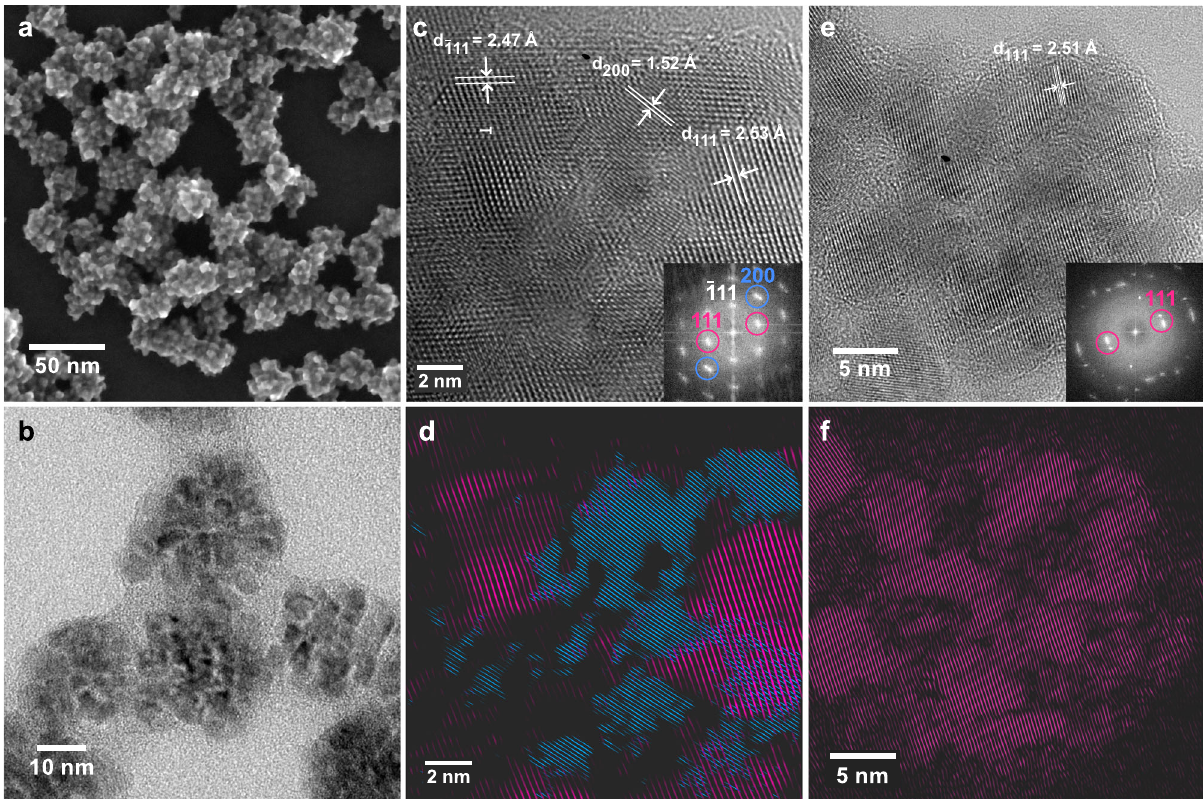
Fig. 1 SEM and TEM images of CoO assemblies at the end of the reaction. Different magni fi cations highlight their hierarchical structure. a Probe- corrected SEM image of spherical assemblies built of irregularly shaped crystallites. b TEM image of assemblies grown after 90 min of reaction time. c HR- TEM image and the corresponding Fourier transformation (FT) (inset) reveal that an assembly exhibits different crystallite orientations. A dislocation in the (111) plane is marked with a white T. d Filtered image of c by inverse FT of the frequency components highlighted by circles in c selectively showing the (111) orientation in violet and the (200) orientation in blue. e HR-TEM image of a different assembly and its corresponding FT, and f fi ltered inverse FT of e highlighting only the (111) orientation. Individual crystallites do not align to each other in a common crystallographic